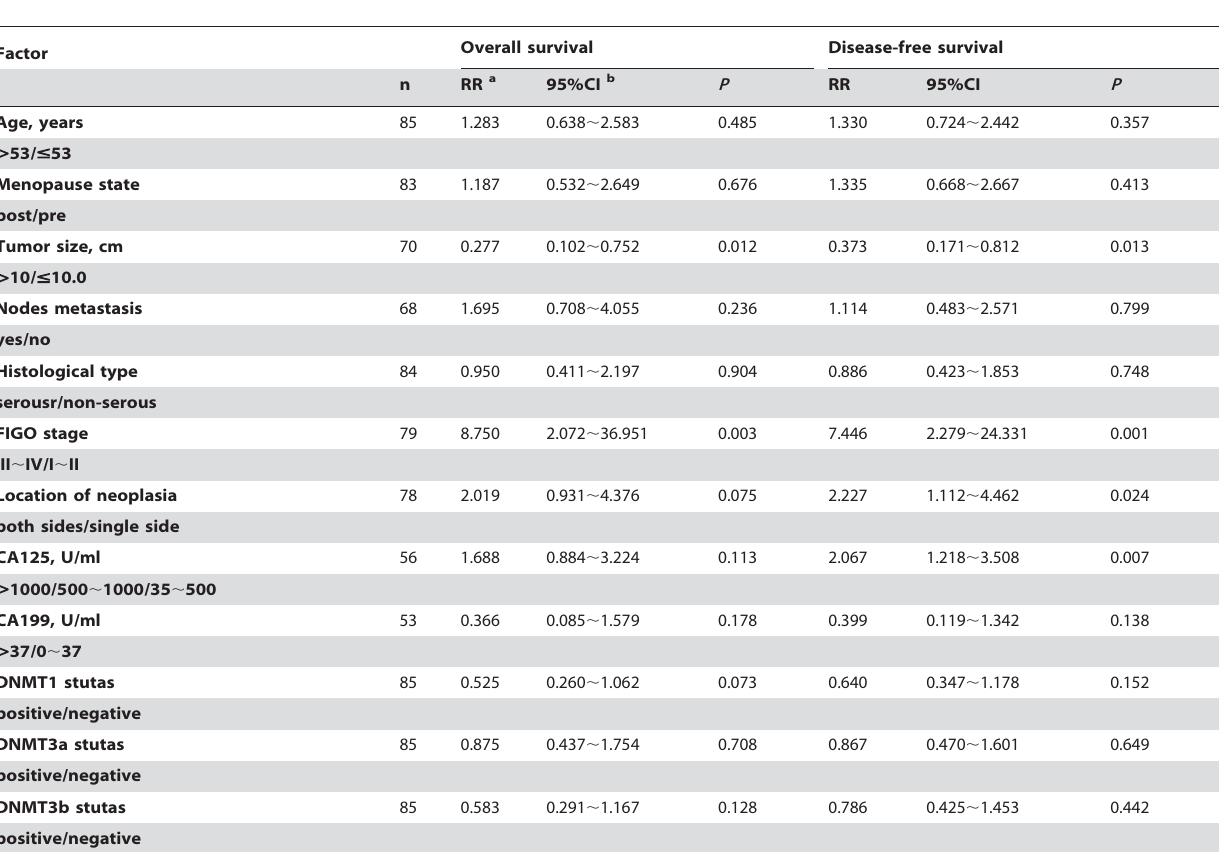
Table 5. Univariate Cox regression analysis of clinical and pathological data correlated with OS and DFS in total ovarian cancers.